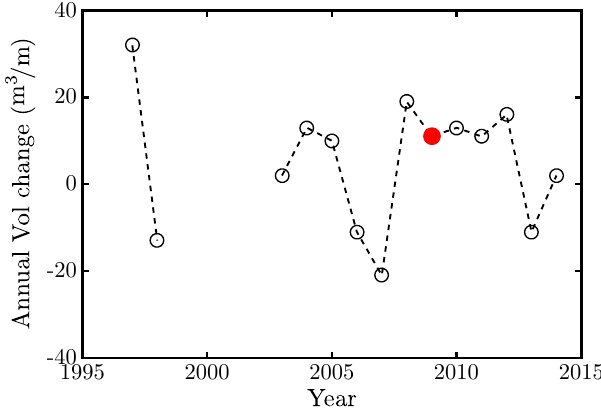
Figure 5. Annual dune volume variation above 3 m+NAP at Egmond Beach. The red dot represents the volume increase during the year 2009 (March 2009–March 2010). For the years 2000 and 2002 there are no data available and therefore, no volume change is plotted for the years that depend on these measurements, i.e., 1999, 2000, 2001 and